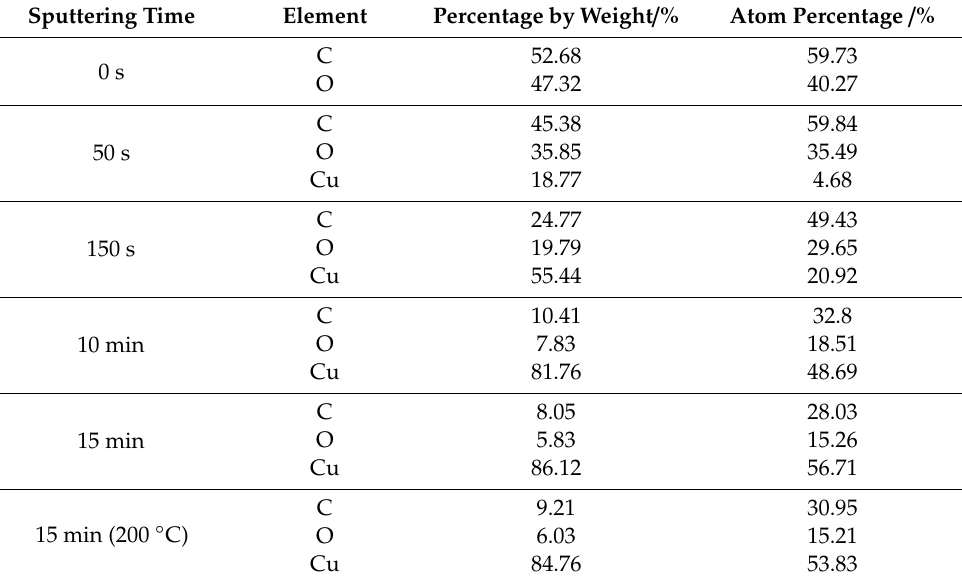
Table 4. Weight percentage of surface elements before and after